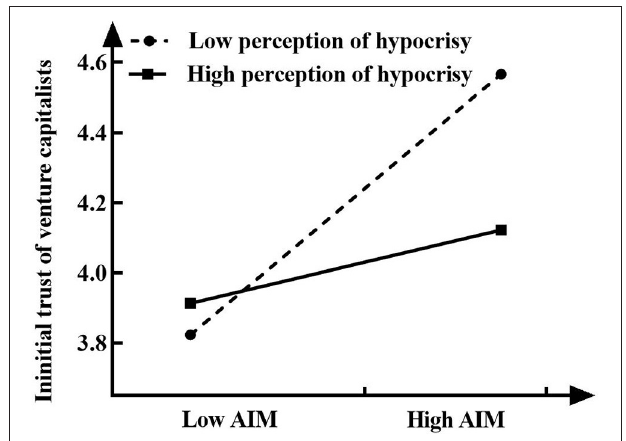
FIGURE 2 | Interactive effect of the acquired impression management strategies and perception of hypocrisy on initial trust of venture capitalists.